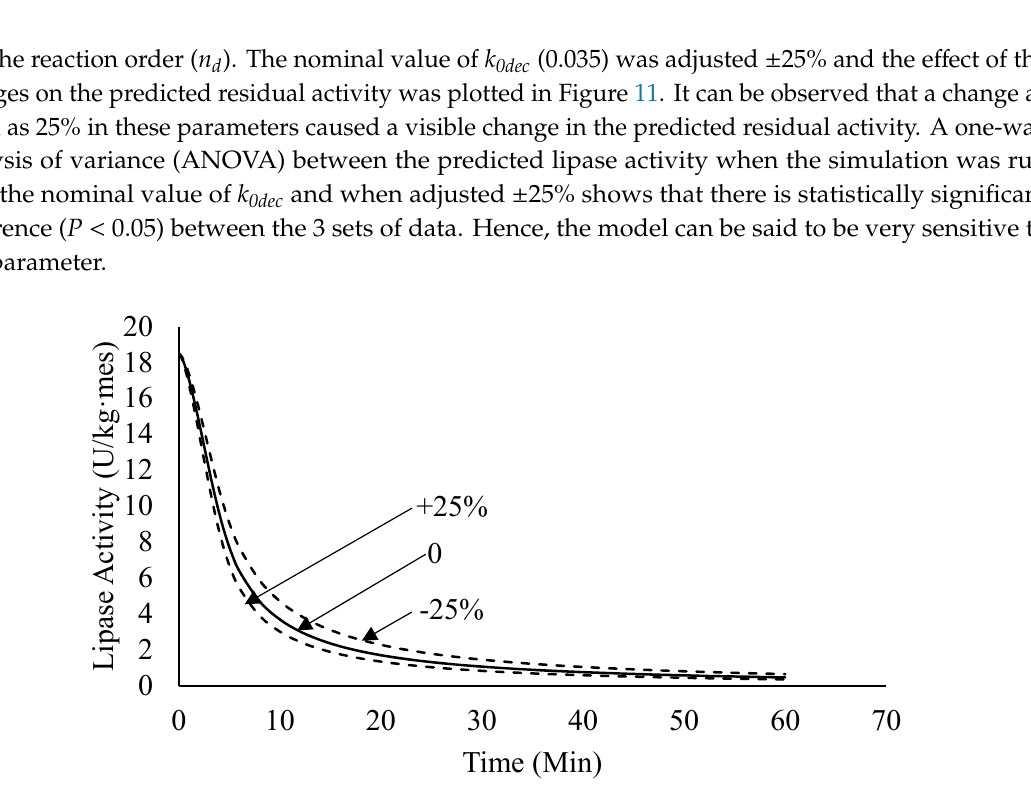
Figure 11. Sensitivity analysis of the developed model to changes in value of k 0dec with respect to predicted in vivo residual lipase activity inside OPF after immersion in hot water at 343 K for 60 min.